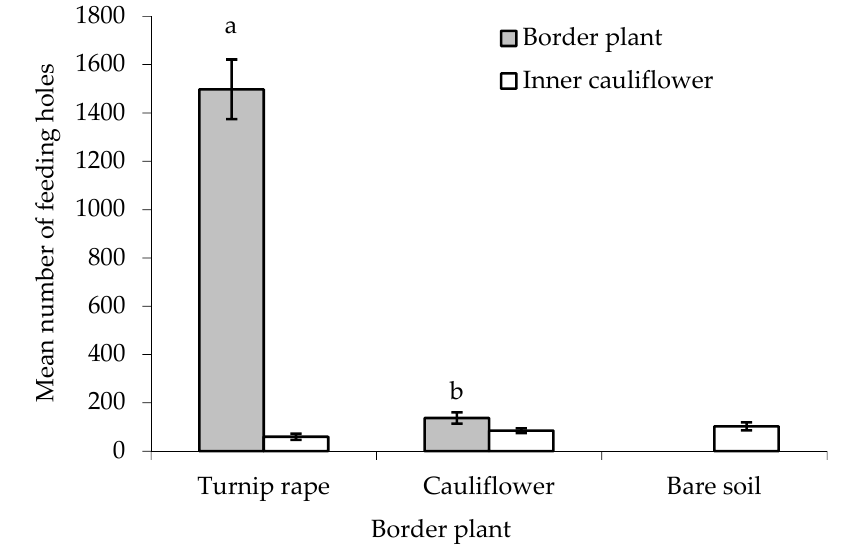
Figure 4. Number of flea beetle feeding holes (mean ± SE) on leaves of turnip rape or cauliflower plants used for the border and in ‘inner’ cauliflower plants under different treatments. n = 10 for all means. Means with different letters (a–b) denote statistically significant differences between treatments.